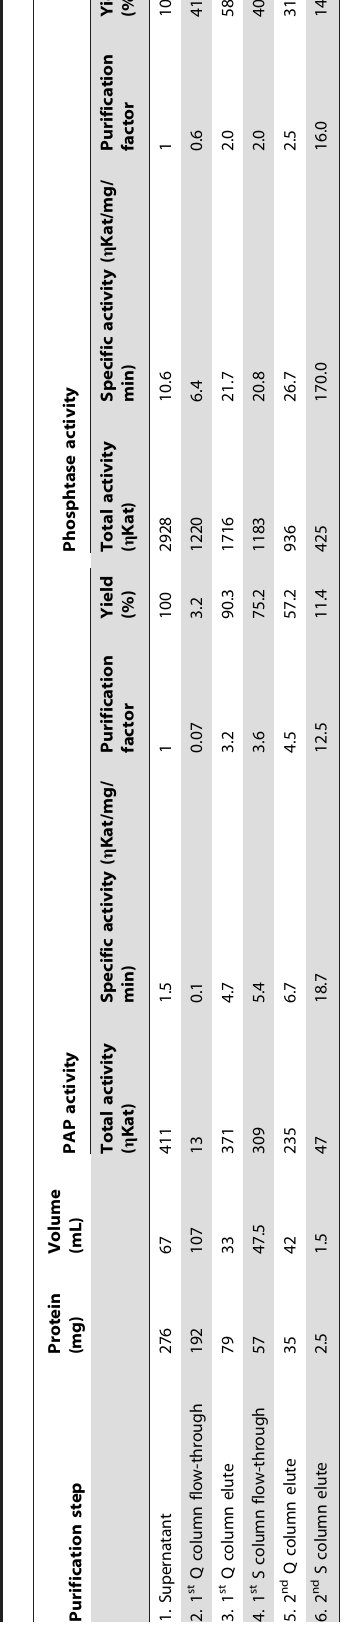
(Table 2). MS/MS identified four of the proteins in both trypsin and GluC digests corresponding to ribosome-inactivating protein momordin I, elastase inhibitor 4, malate dehydrogenase and trypsin inhibitor 2 (Table 2). However, none of the ms corresponded to PAP sequences in other species. These MS/MS results suggest that PAP protein is probably associated with other proteins and that PAP itself is a minor component in the purified fraction.